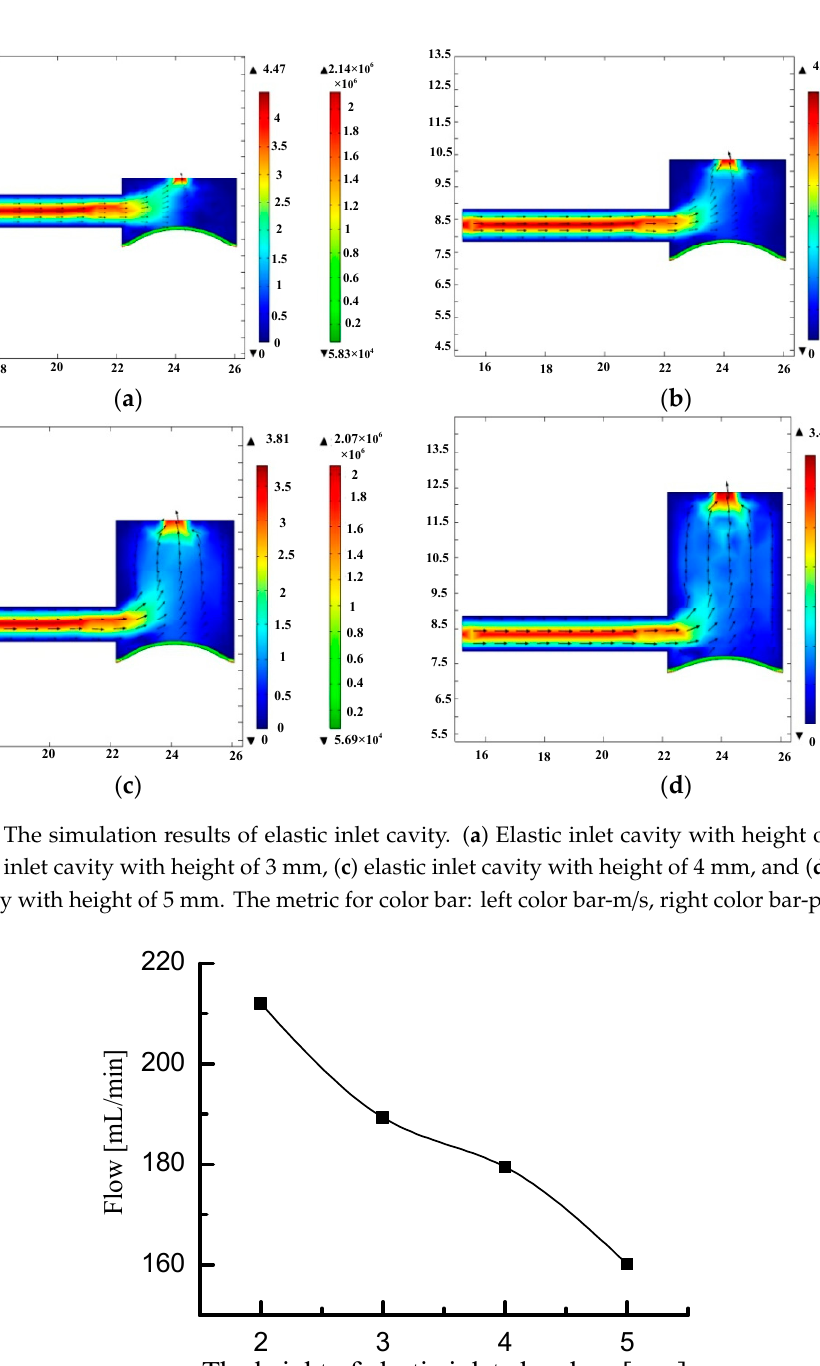
Figure 7. The flow rate at port A corresponding to different heights of elastic inlet cavity. The fluid motion within the elastic outlet cavity was then simulated. Port A and port B were defined as the fluid inlet and fluid outlet of the 2D model, respectively. Taking into account the inflow and outflow characteristics of the water in the elastic outlet cavity, the pressure at port A and port B should be set to positive pressure and zero pressure, respectively. We set the pressure at port A and port B to 15 kPa and 0, respectively. The settings of the elastic diaphragm and the fluid medium were the same as those in the simulation of the elastic inlet cavity. Fluid-structure coupling simulations were performed for the elastic outlet cavity with heights of 2 mm, 3 mm, 4 mm, and 5 mm, respectively. The simulation results are shown in Figure 8. The flow rate at port B was calculated as shown